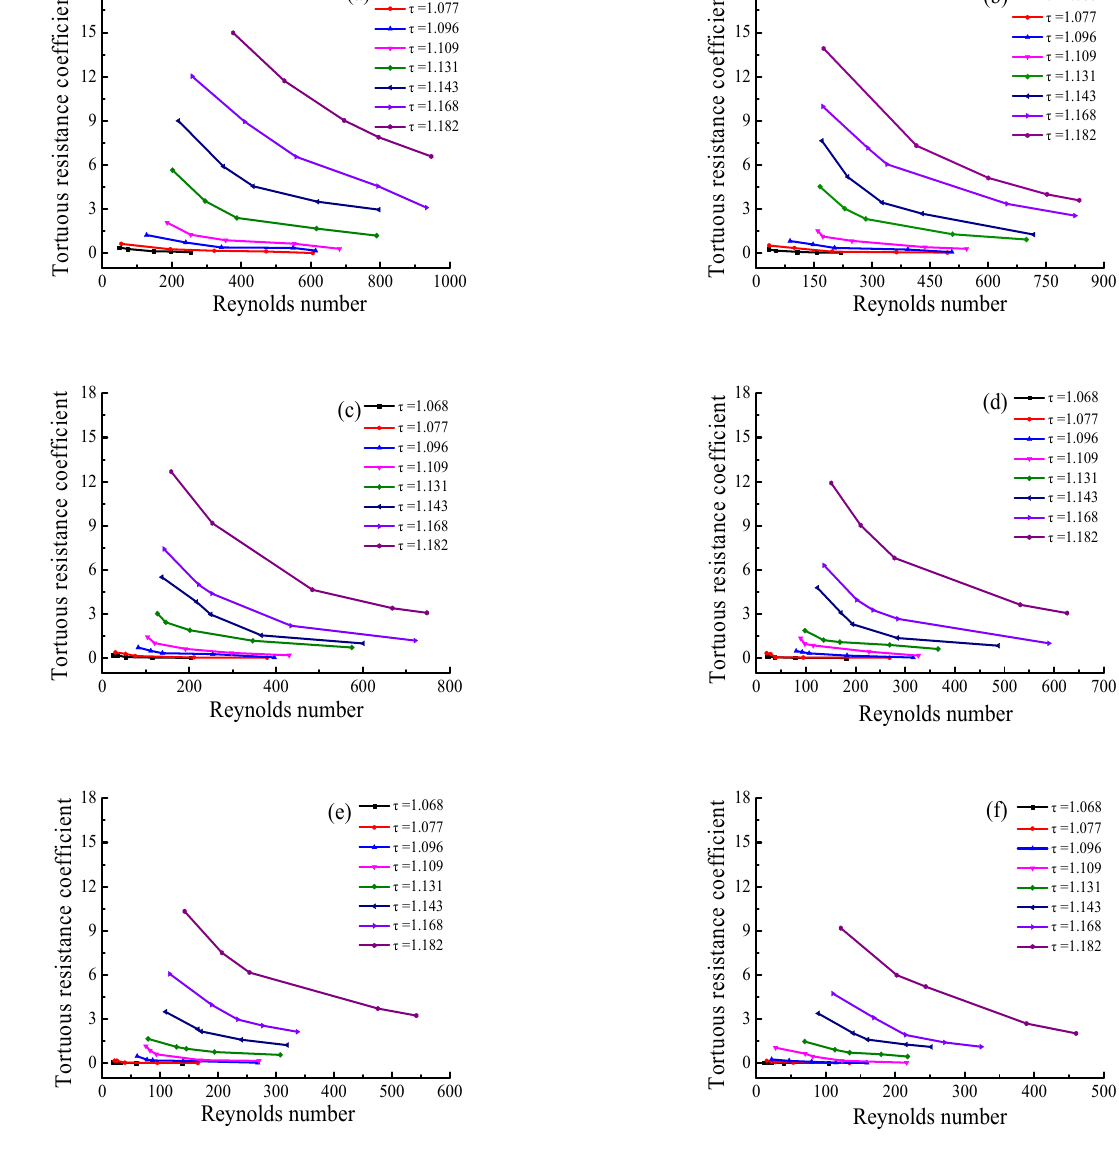
Figure 9. Relation between Reynolds number and tortuous resistance coefficient at different tortuosity under different normal pressures. ( a ) Normal stress = 0.10 MPa, ( b ) Normal stress = 0.15 MPa, ( c ) Normal stress = 0.20 MPa, ( d ) Normal stress = 0.25 MPa, ( e ) Normal stress = 0.30 MPa, ( f ) Normal stress = 0.40 MPa.